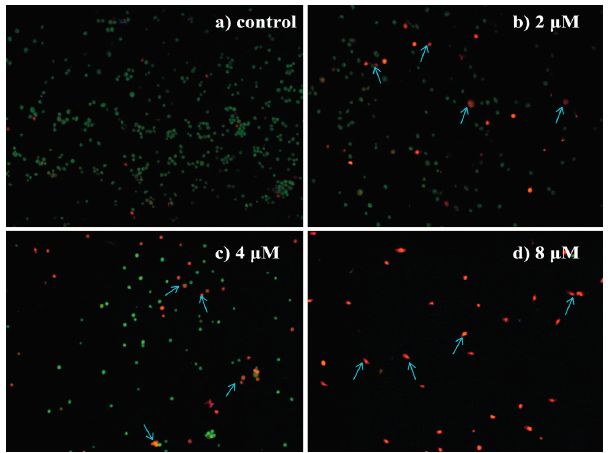
Figure 4. Morphological observation of HepG2 cells using AO/EB double staining (200×): ( a ) control group; ( b ) 2 μ M; ( c ) 4 μ M; and ( d ) 8 μ M. The cell morphology was examined